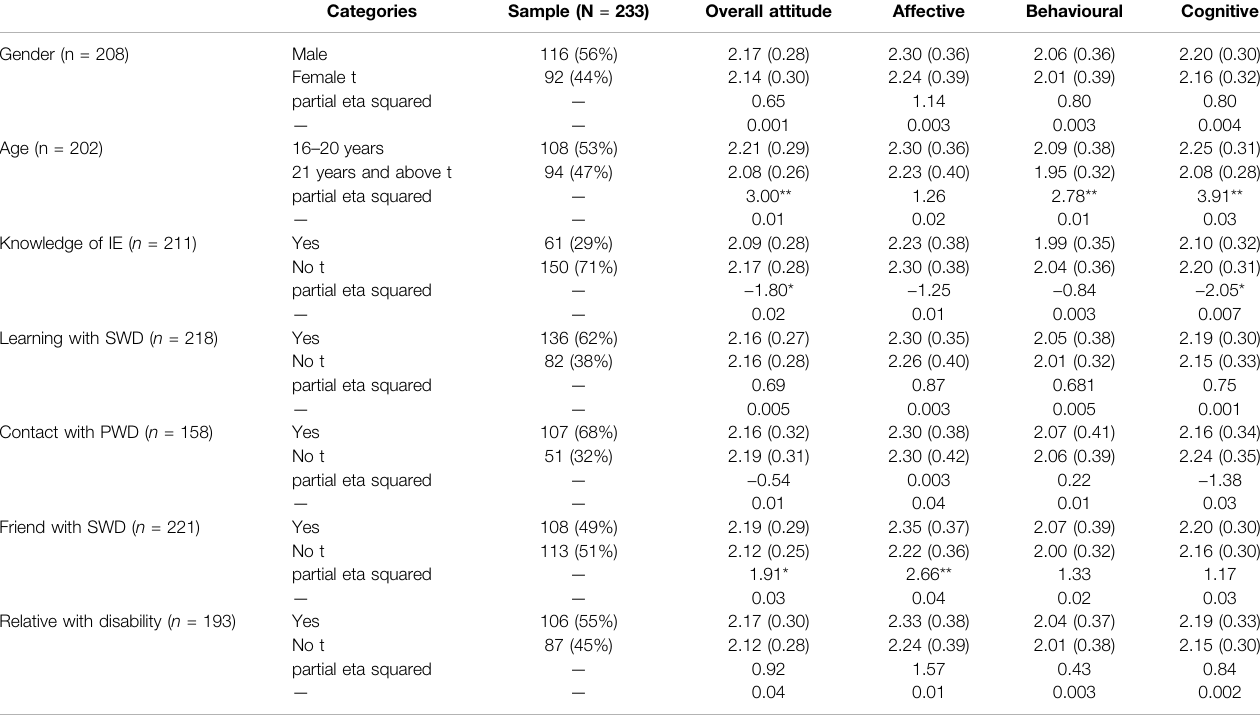
TABLE 2 | In fl uence of demographic pro fi le on attitudes. Categories Sample (N = 233) Overall attitude Affective Behavioural Cognitive